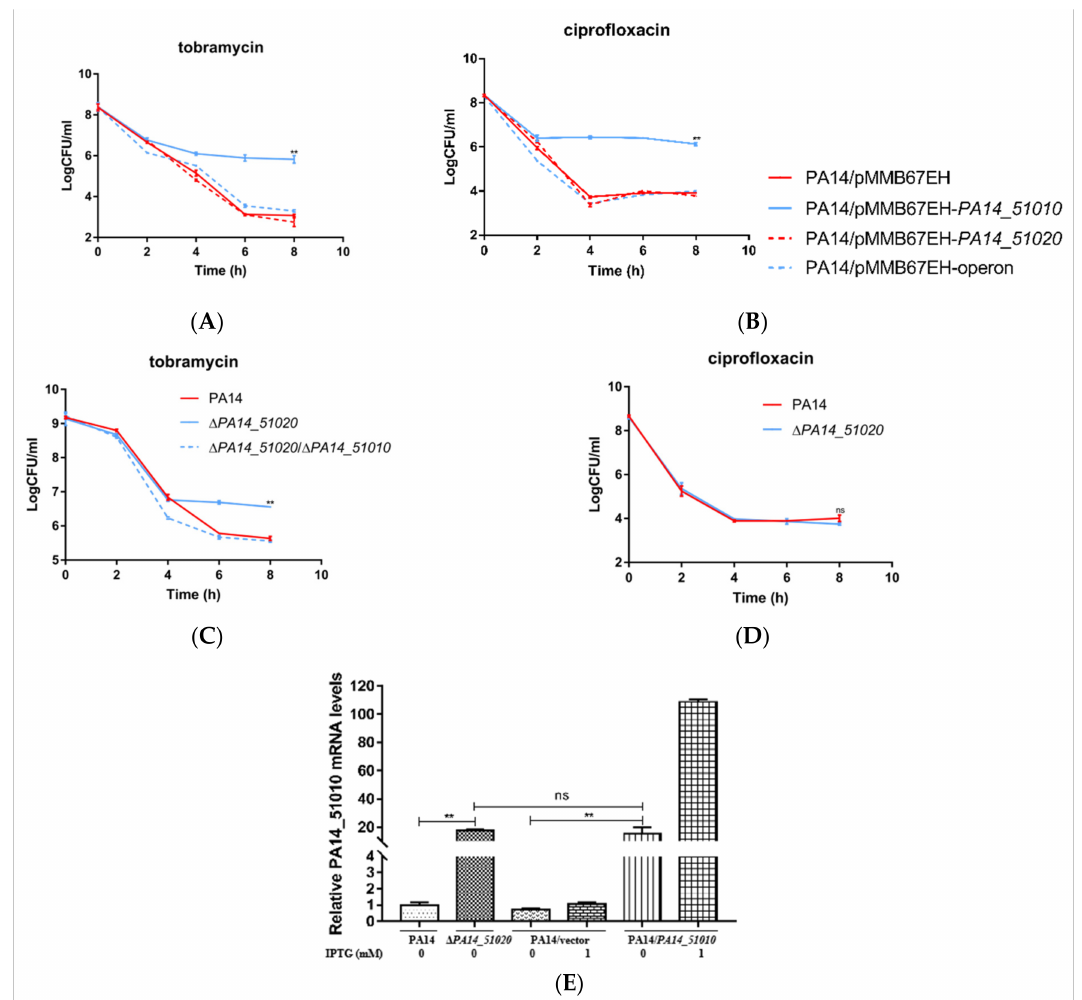
Figure 4. PA14_51020 and PA14_51010 regulate persister formation. ( A , B ) Wild-type PA14 carrying pMMB67EH, pMMB67EH- PA14_51010 , pMMB67EH- PA14_51020 or the pMMB67EH-operon ( PA14_51020-PA14_51010 ) were treated with 5 µ g/mL tobramycin ( A ) or 0.5 µ g/mL ciprofloxacin ( B ). At indicated time points the live bacteria numbers were determined by serial dilution and plating assay. ( C ) Wild-type PA14 and the ∆ PA14_51020 and ∆ PA14_51020 ∆ PA14_51010 mutants were treated with 5 µ g/mL tobramycin. At indicated time points the live bacteria numbers were determined by serial dilution and plating. ( D ) Wild-type PA14 and the ∆ PA14_51020 mutant were treated with 0.5 µ g/mL ciprofloxacin. At indicated time points the live bacteria numbers were determined by serial dilution and plating. **, p < 0.01 compared to the other samples by Student’s t test. ( E ) Total RNAs were isolated from the indicated strains at an OD 600 of 1.0. The mRNA levels of PA14_51010 were determined by quantitative RT-PCR. The ribosomal protein coding gene rpsL was used as an internal control. Data represent the results from three independent experiments. **, p < 0.01, ns, not significant, by Student’s t